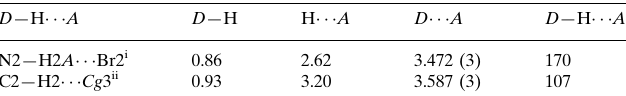
Hydrogen-bond geometry (A˚ , (cid:2)